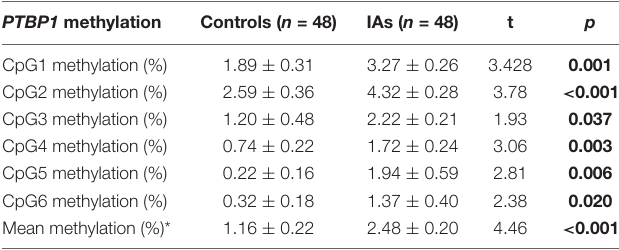
TABLE 2 | DNA methylation difference of six CpG dinucleotides comparison within the PTBP1 between IAs and Controls.